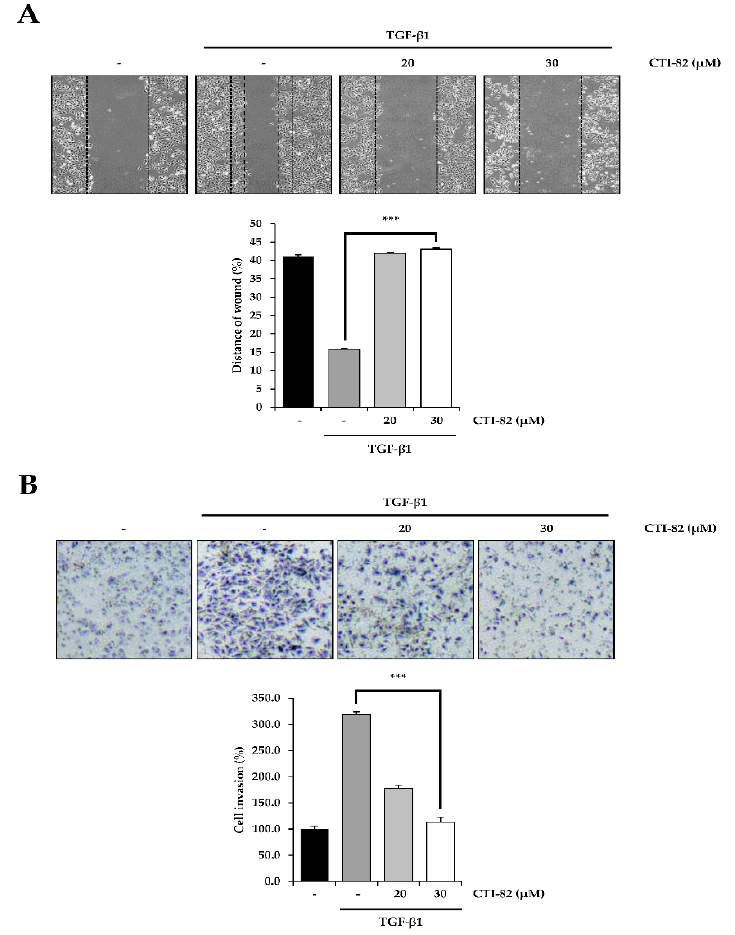
Figure 6. CTI-82 suppresses TGF- β 1-induced cell migration and invasion. ( A ) CTI-82 inhibits migration induced by TGF- β 1. Wound-healing assay results show the amount of movement in A549 cells treated with TGF- β 1 for 2 h and then CTI-82 for 48 h. Quantitative histograms show the average level observed in three random fields for each condition. ( B ) CTI-82 inhibits invasion induced by TGF- β 1. A549 cells were treated with TGF- β 1 (5 ng / mL) for 2 h, followed by CTI-82 for 48 h. A549 cells invaded after 48 h were detected and analyzed by the Matrigel invasion assay. Invasiveness was measured by counting cells in the matrix layer of the invasive chamber. *** p -value < 0.001 versus TGF- β 1 alone. The data are expressed as the mean ± SD for triplicates.